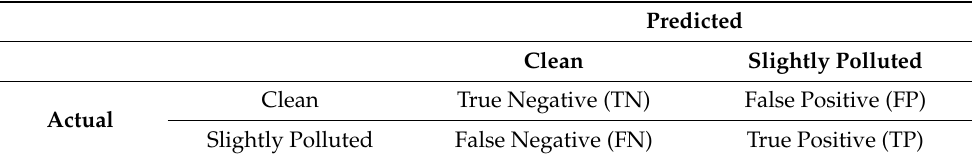
Table 5. Confusion matrix for binary